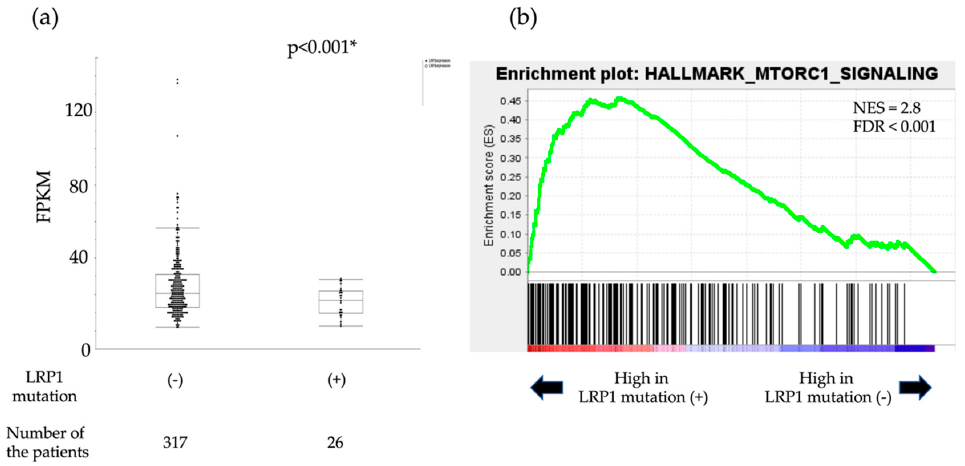
Figure 3. In silico approaches to predict the role of LRP1 mutation. ( a ) Boxplot representing the mRNA level in The Cancer Genome Atlas Stomach Adenocarcinoma (TCGA–STAD) cohort. Fragments per kilobase of exon per million (FPKM) mapped those in Figure 1 with mutation and those without mutation. ( b ) The enrichment plot, light green line, providing a graphical view of the enrichment score for MTORC1 signaling gene. The score at the furthest positive peak indicates the enrichment